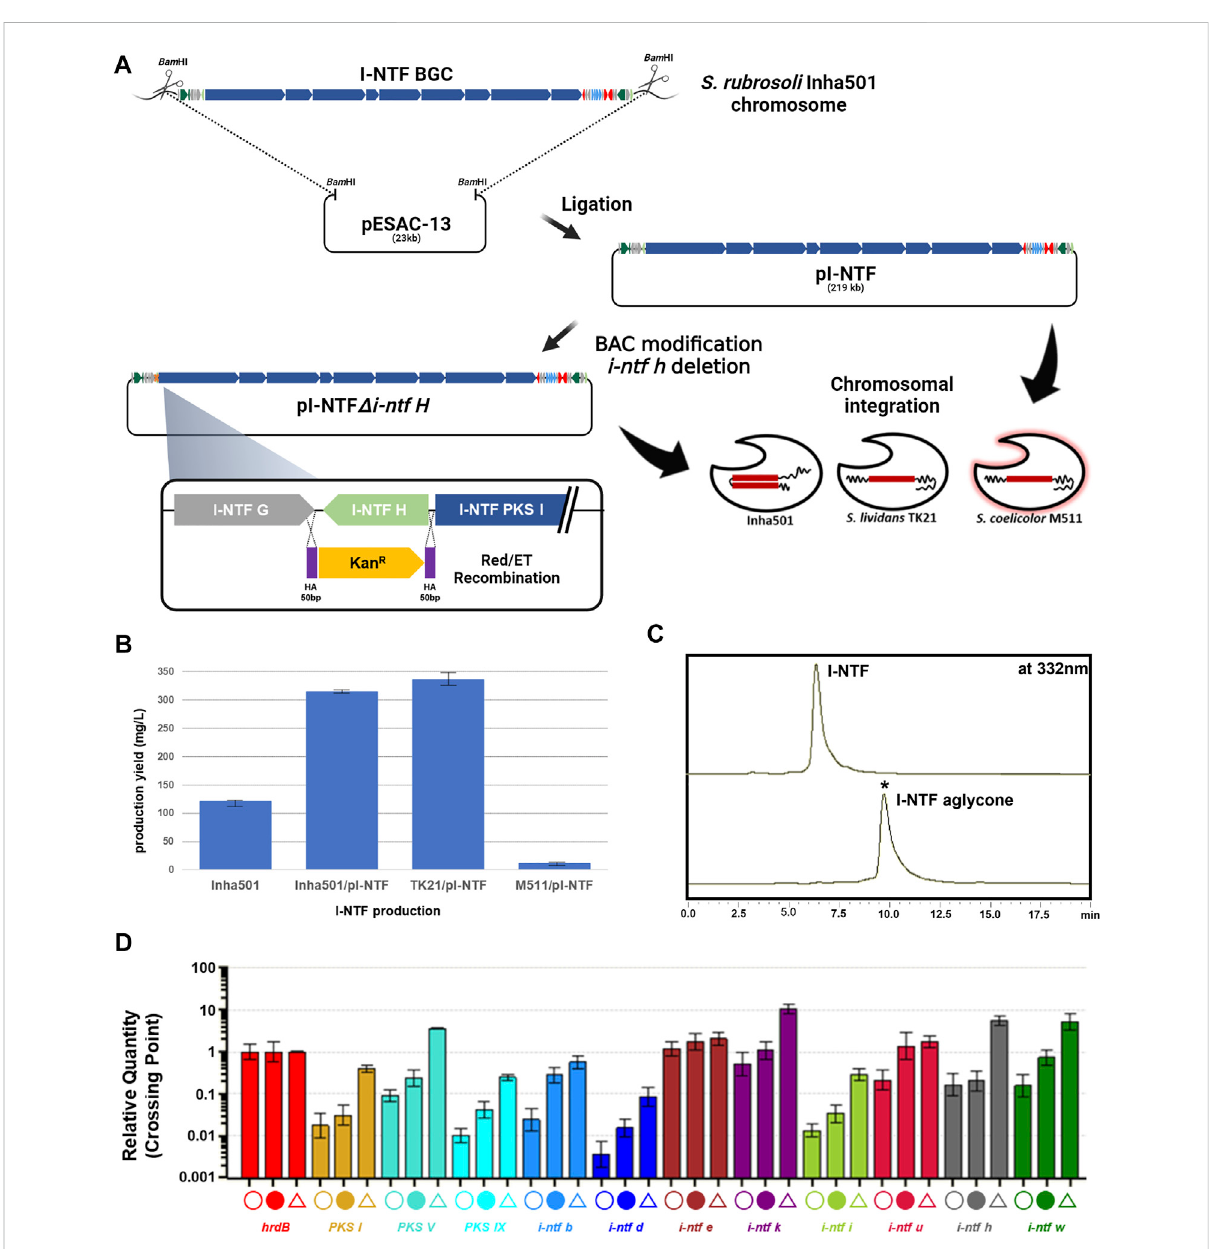
FIGURE 3 (A) Construction scheme of I-NTF and I-NTF aglycone production strains. (B) Comparison of I-NTF production yields after 7 days of culture. (C) HPLC chromatograms of the cultures from the S. rubrisoli Inha501 (upper line) and the i-ntf h disrupted S. rubrisoli Inha501 mutant (lower line). The asterisked peak is con fi rmed to be the I-NTF aglycone. (D) Transcript analysis of I-NTF production strains by qRT-PCR. Open circle, transcripts from S.rubrisoli Inha501 at120 h;closed circle, transcriptsfromtheI-NTF over-production mutant( S.rubrisoli Inha501/pI-NTF)at120 h; open triangle, transcripts from the I-NTF heterologous production mutant ( S. lividans TK21/pI-NTF) at 120 h; house-keeping gene, hrdB (red); PKS genes, PKS I (yellow), PKS V (emerald), and PKS IX (sky blue); regulatory genes, I-NTF B (blue) and I-NTF U (dark red); Post-PKS genes, I-NTF H (gray) and I-NTF W (dark green); other genes, I-NTF D (dark blue),I-NTF E (brown), I-NTF K (dark purple), and I-NTF I (green). All transcript measurements were performed in duplicate (Created with